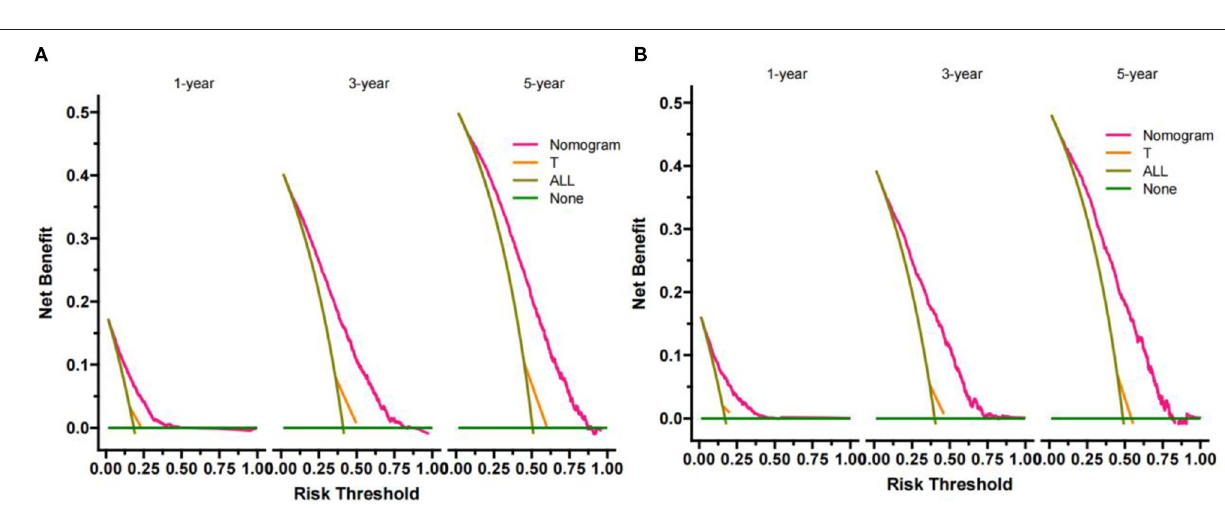
FIGURE 5 | DCA of the nomogram in training cohort (A) and validation cohort (B) . The Y-axis represents a net benefit, and the X-axis represents threshold probability. The green line means no patients died, and the dark green line means all patients died. When the threshold probability is between 0 and 75%, the net benefit of the model exceeds all deaths or